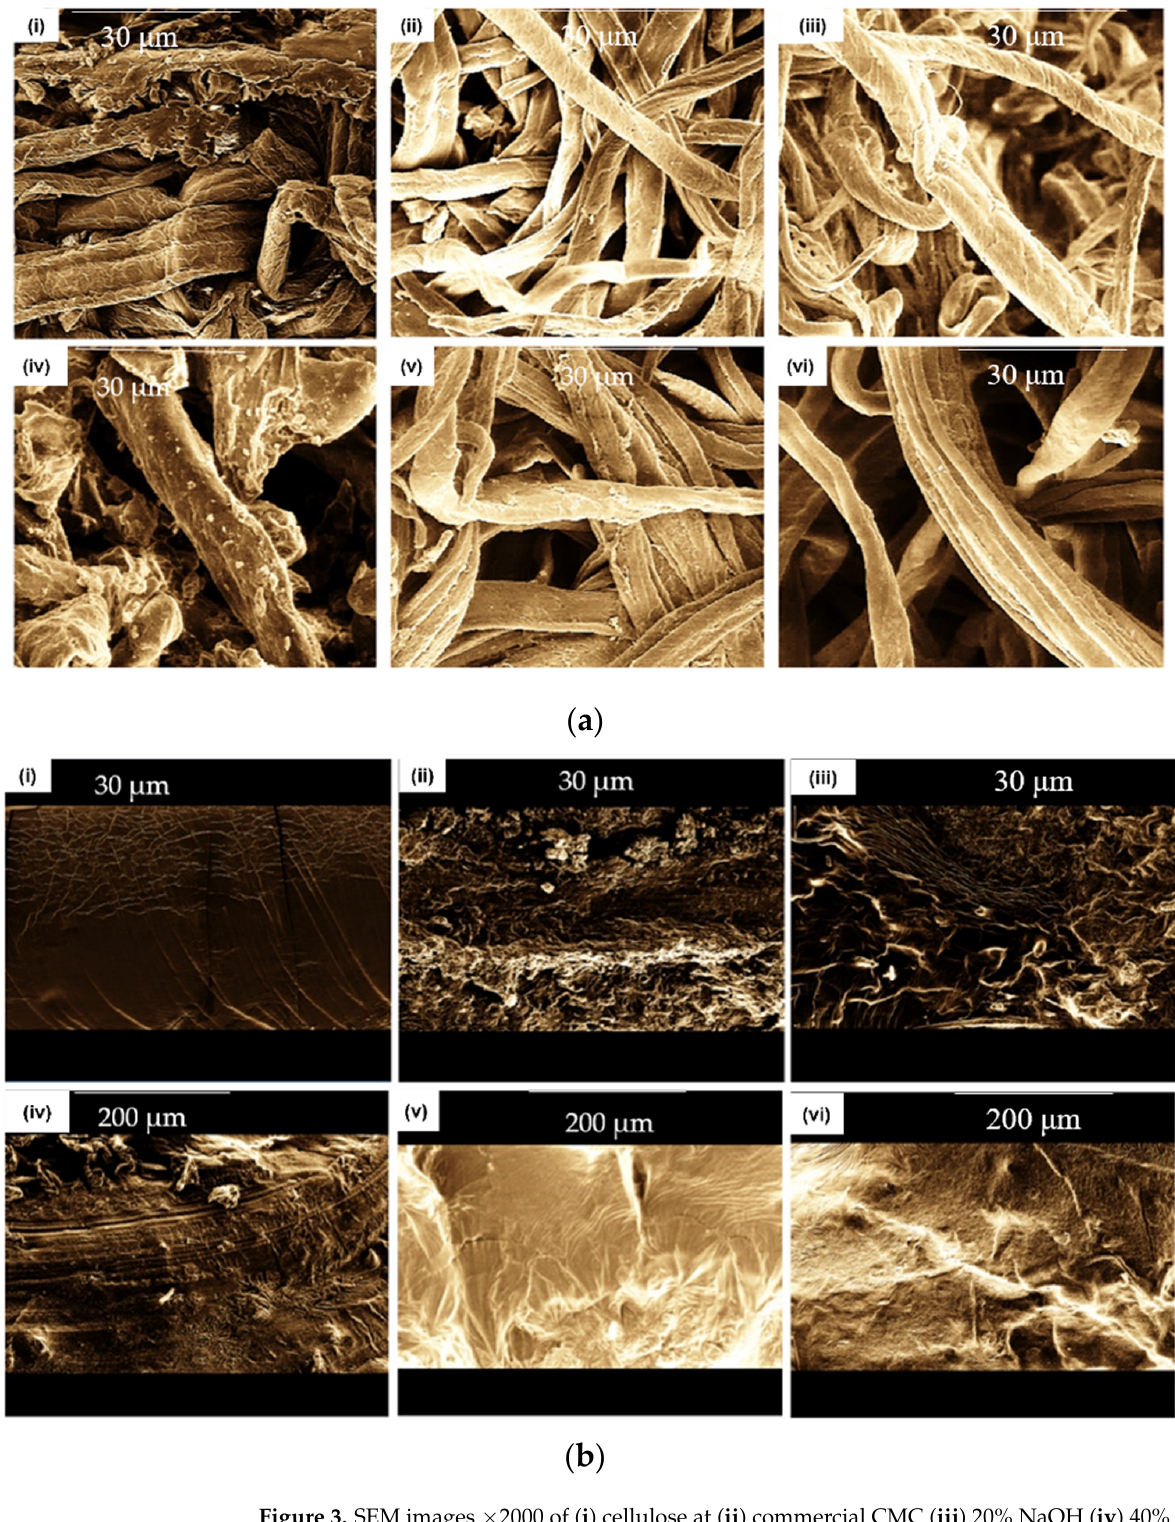
Figure 3. SEM images × 2000 of ( i ) cellulose at ( ii ) commercial CMC ( iii ) 20% NaOH ( iv ) 40% NaOH ( v ) 60% NaOH ( vi ) and 70% NaOH at × 2000 ( a ); SEM images of cross-section of OCMC film at × 300 for ( i ) CCMC ( ii ) 30% NaOH ( iii ) 40% NaOH ( iv ) 50% NaOH ( v ) 60% NaOH and ( vi ) 70% NaOH ( b ).